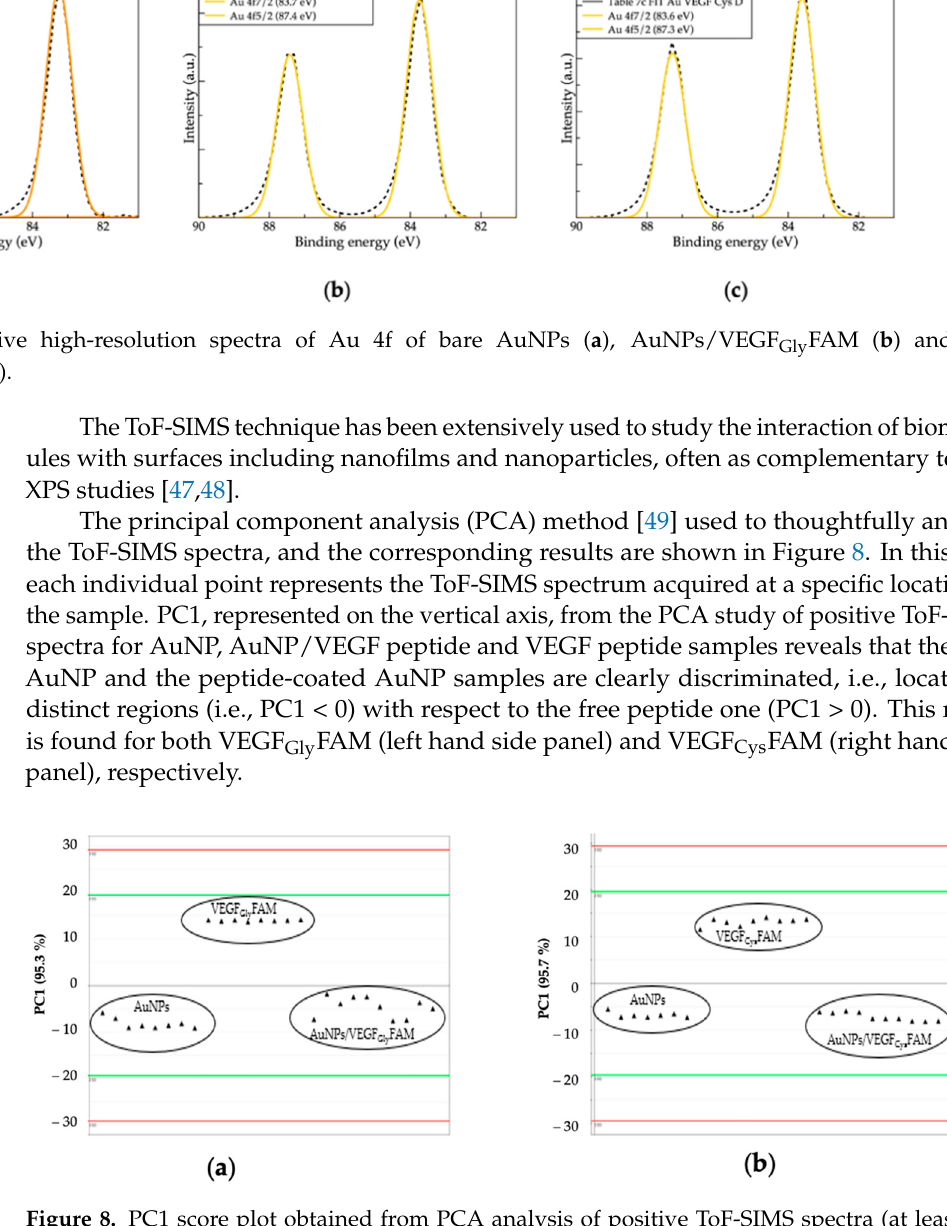
Figure 9. PC1 Score Plot obtained from PCA analysis of positive ToF-SIMS spectra (at least five spectra for each sample) of bare and functionalized AuNPs with VEGF Gly FAM peptide ( a ) and VEGF Cys FAM ( b ). The PC1 score plots well discriminate between two samples, and a higher separation is obtained for the ensembles of PC1 values of AuNP vs. AuNP/VEGF Gly FAM than those of AuNP vs. AuNP/VEGF Cys FAM. According to the picture figured out from UV-visible and XPS analyses, this finding is explained in terms of the higher peptide coverage of the gold nanoparticles by VEGF Gly FAM with respect to VEGF Cys FAM. The loadings plots related to the PC1 score plots above-described focus on the most significant peaks of the considered samples. The PC1 loadings list for the AuNPs/VEGF Gly- FAM, reported in Table 2, distinguishes a main Na + fragment located a negative PC1 value, which can be considered characteristic of naked AuNPs due to the layer of citrate used during the reduction reaction. Instead, positive PC1 values are observed for all char- acteristic fragments related to the functionalized peptide at the surface of AuNPs. Most of them can be correlated to aminoacidic residues (selected in bold in the table) as Wagner et al. have reported [50], specific of the VEGF Gly FAM sequence. Among them, also a frag- ment related to Au + was found.